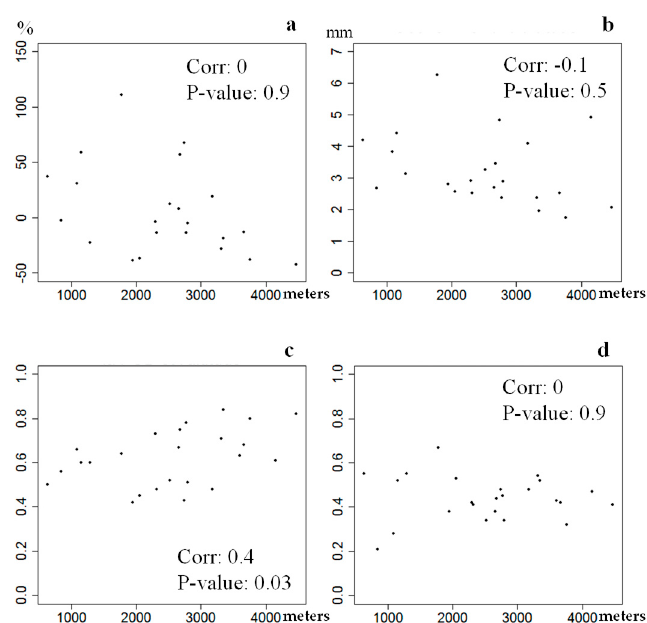
Figure 8. ( a ) Relative RMSE (in mm), ( b ) bias (in mm), ( c ) POD, and ( d ) FAR of 3B42, at daily scale for each month of the year for the five regions: ( i ) the northeast, ( ii ) south, ( iii ) north, ( iv ) center, ( v ) west regions.